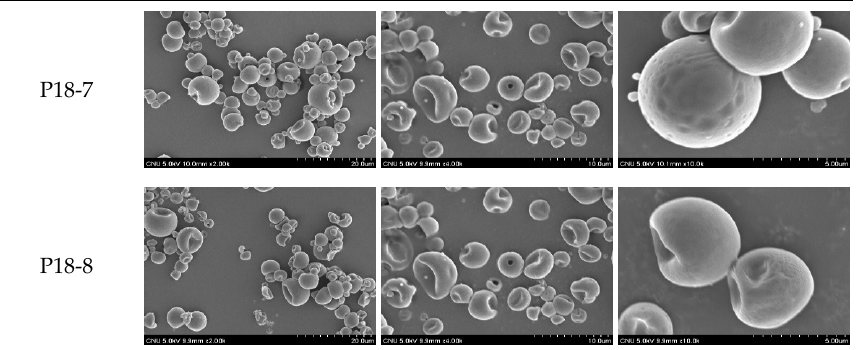
Figure 2. The effect of various spray drying condition on the morphology of spray-dried olive oil powder.